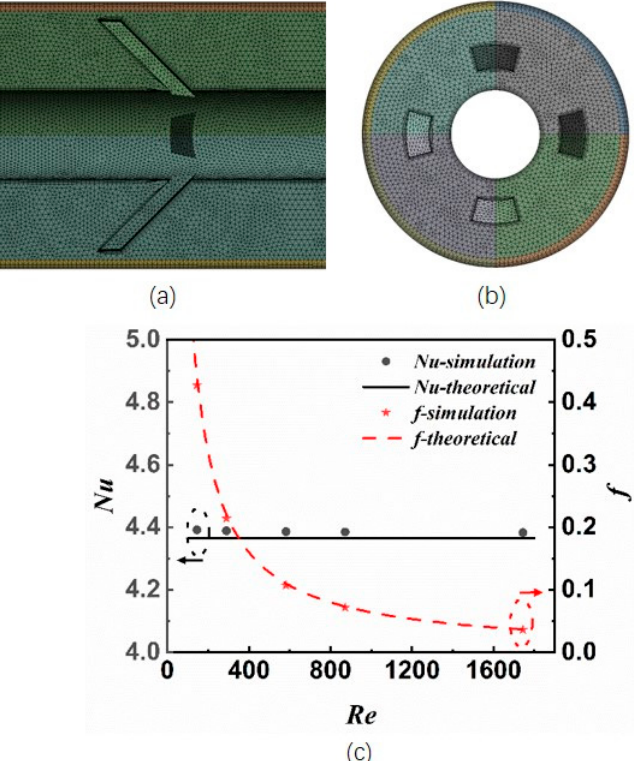
Figure 2. ( a ) Detail view of grid at axial section; ( b ) Detail view of grid at cross section; ( c ) Compar- isons between numerical results and theoretical values for smooth tube.